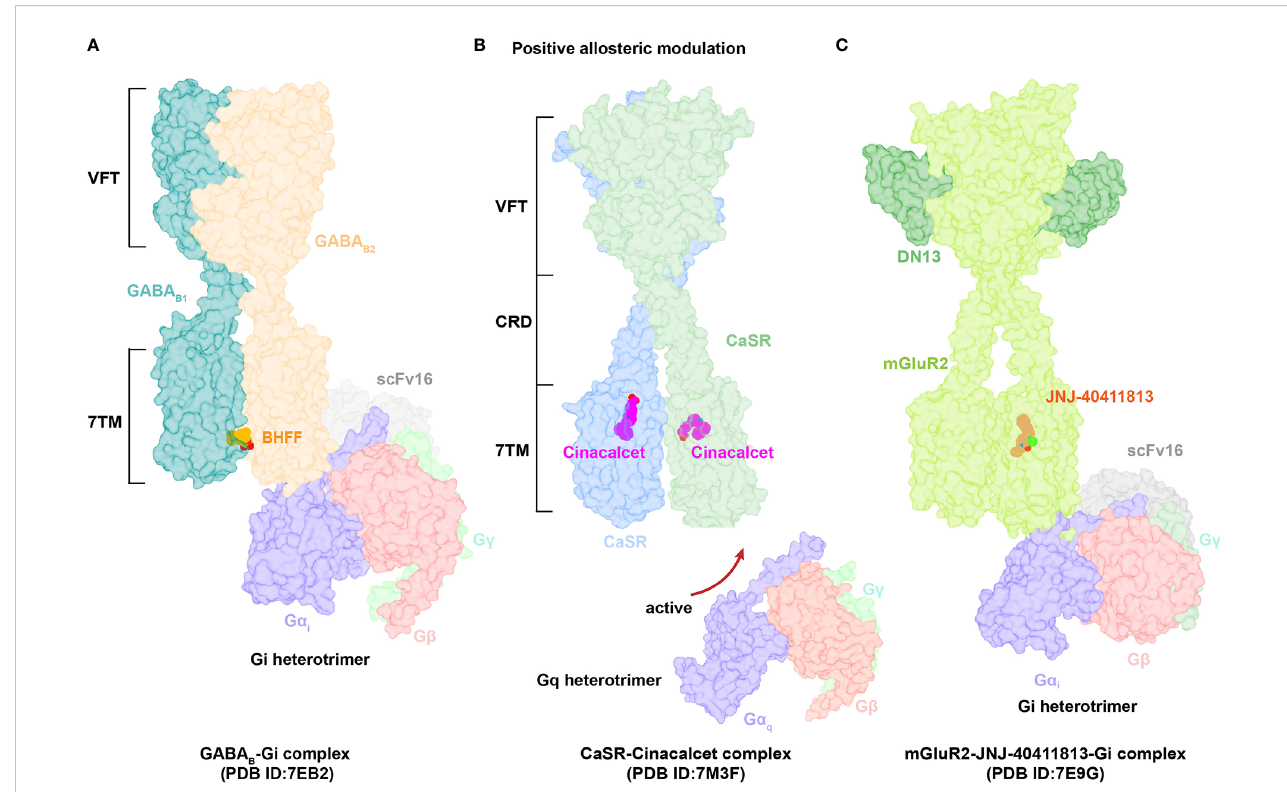
FIGURE 4 Structural basis of allosteric regulation in Class C GPCRs. (A) Cryo-EM structural model of active-state GABA B complexed with PAM BHFF (orange). (B) Cryo-EM structural model of active-state CaSR complexed with PAM cinacalcet (magentas). (C) Cryo-EM structural model of active-state mGluR2 complexed with PAM JNJ-40411813 (salmon).